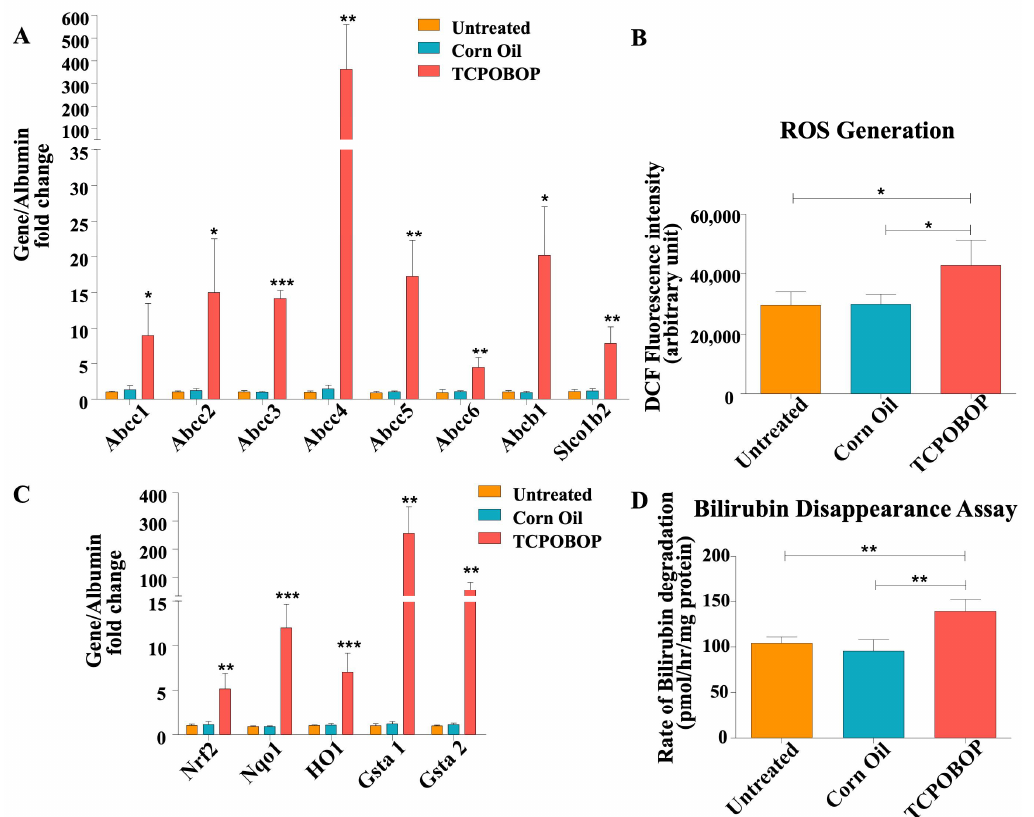
Figure 5. TCPOBOP treatment activates genes involved in bilirubin metabolism and transport, and activates oxidative stress-induced signaling pathways in adult Ugt1 −/− animals. ( A ) qRT-PCR analysis of Abcc1, Abcc2, Abcc3, Abcc4, Abcc5, Abcc6, Abcb1, Slco1b2 in different treatment groups. Albumin was used as the internal control ( n = 3 for each treatment group). ( B ) ROS generation in liver tissue in different treatment groups was determined using DCF-DA. n = 4. ( C ) qRT-PCR analysis of Nrf2, Nqo1, HO1, Gsta1, Gsta2 in different treatment groups. Albumin was used as the internal control. ( n = 3 for each treatment group). ( D ) Bilirubin disappearance assay using liver microsomes from different treatment groups. Isolated microsomes were incubated with 10 μM bilirubin and the degradation rate was expressed as pmol/hr/mg protein ( n = 4 for each treatment group). Values represent mean ± SD. One way ANOVA test was followed by Bonferroni’s multiple comparison test. *** p < 0.001, ** p < 0.01, * p < 0.05 were interpreted as statistically significant. The treatment groups were: Untreated, Corn Oil (vehicle control), and